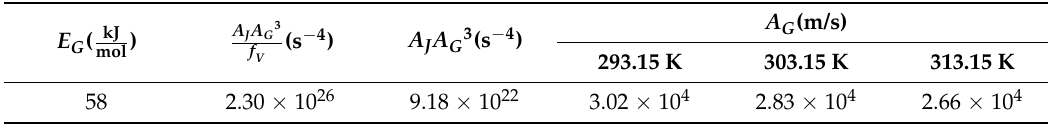
Table 4. The fitted results of E G and A G using Equation (12).